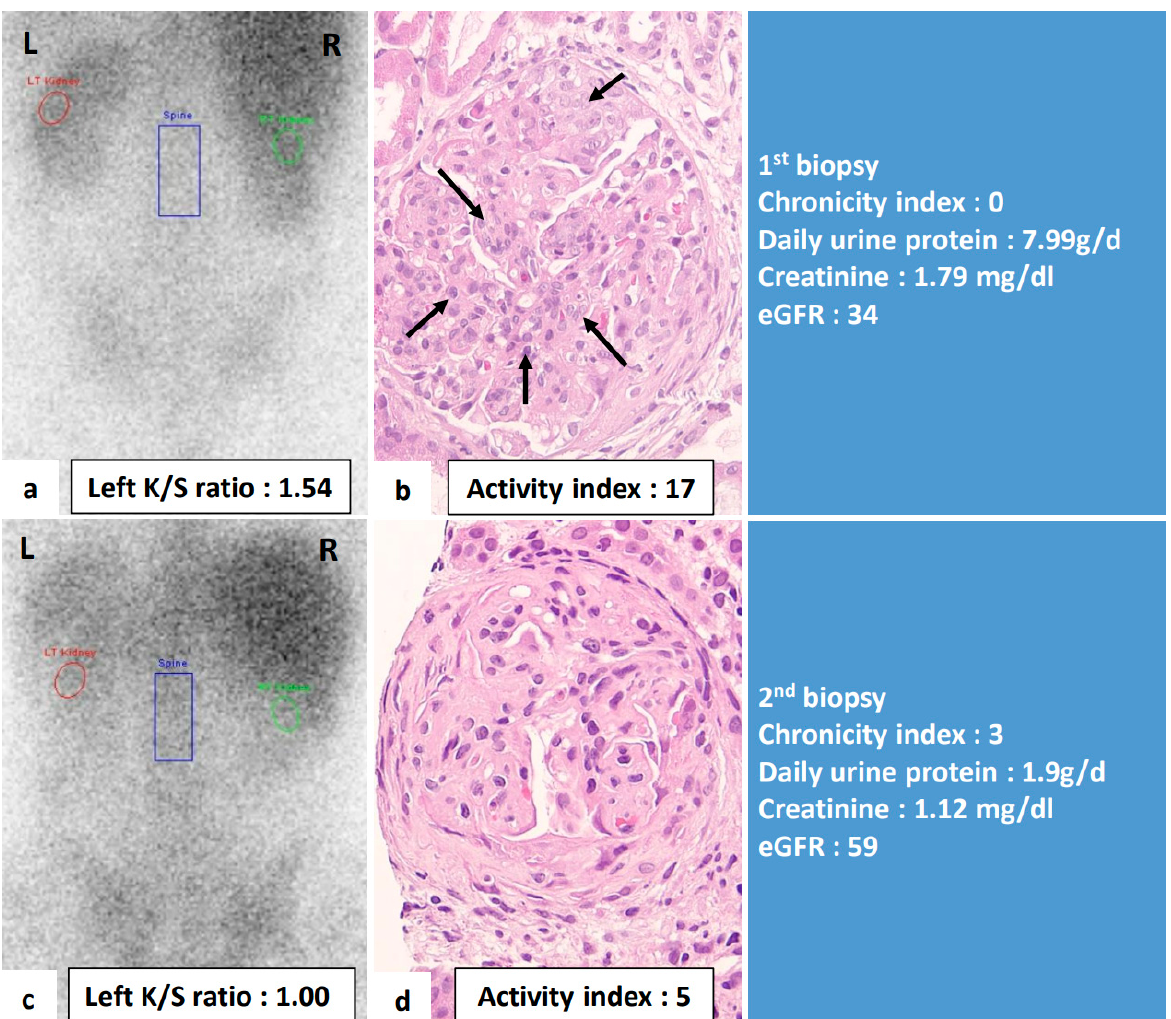
Figure 3. Renal gallium scan and renal histopathologic images in a 36-year-old female with lupus nephritis at diagnosis and one year after immunosuppressant treatment. This figure demonstrated that the change of renal gallium uptake was positively correlated with the change of the inflammatory status in renal histology and clinical proteinuria. ( a , b ) At diagnosis, renal pathology active index score was 17. The Left K/S ratio was 1.54. Daily urine protein was 7.99 g/d. ( c , d ) One year after immunosuppressant treatment, the activity index decreased to 5, left K/S ratio decreased to 1.00. Daily urine protein decreased to 1.9 g/d. L: left side; R: right side; K/S ratio: kidney/spine ratio; arrows: endocapillary hypercellularity.